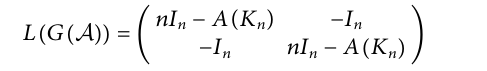
FIGURE 2 | An example of B , n (cid:1) 7, p (cid:1)